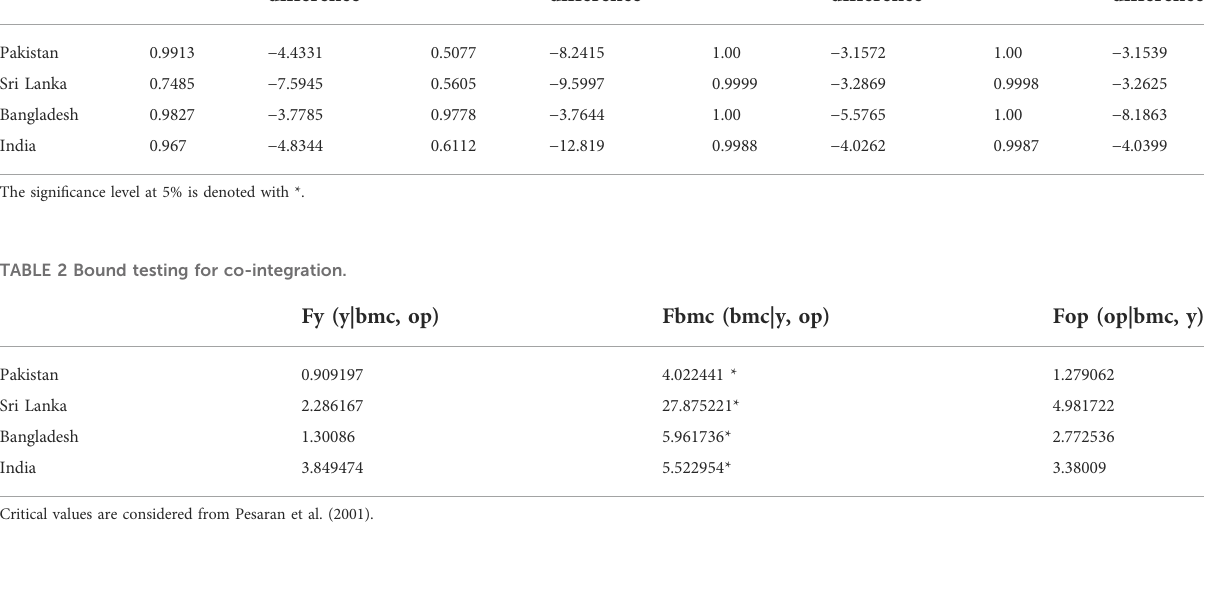
TABLE 3 Short- and long-run coef fi cients for